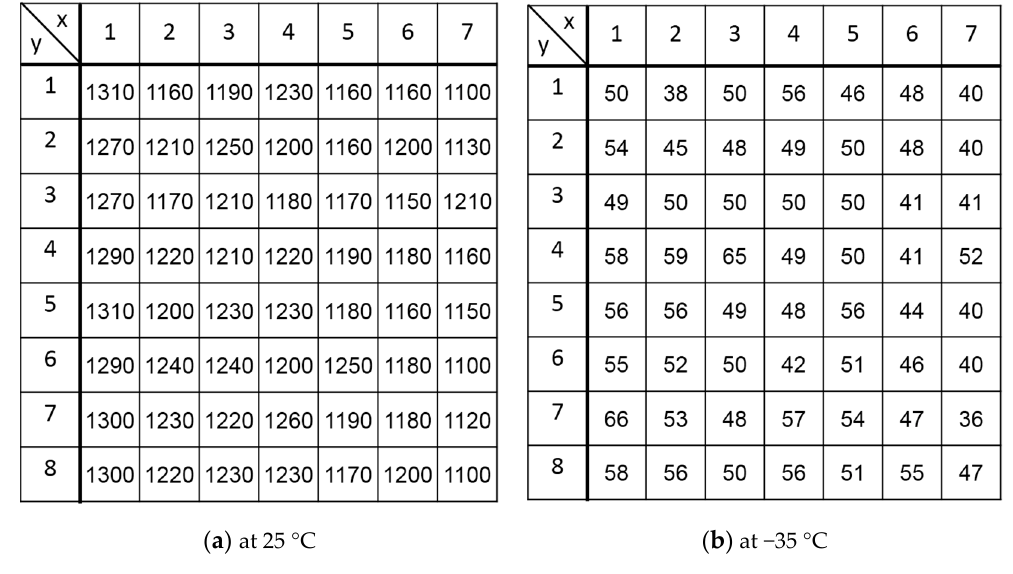
Figure 16. Pixel-to-pixel deviation of dark current.